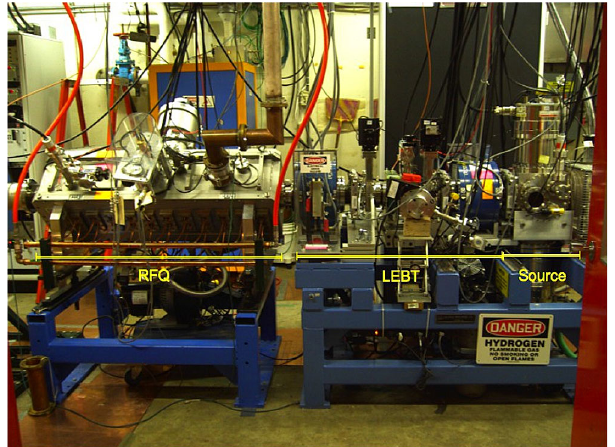
FIG. 6. A high bandwidth Faraday cup is connected to the end of the RFQ for bunch length measurements. For beam current measurements, the Faraday cup is removed and the toroid is connected directly to the end of the RFQ.